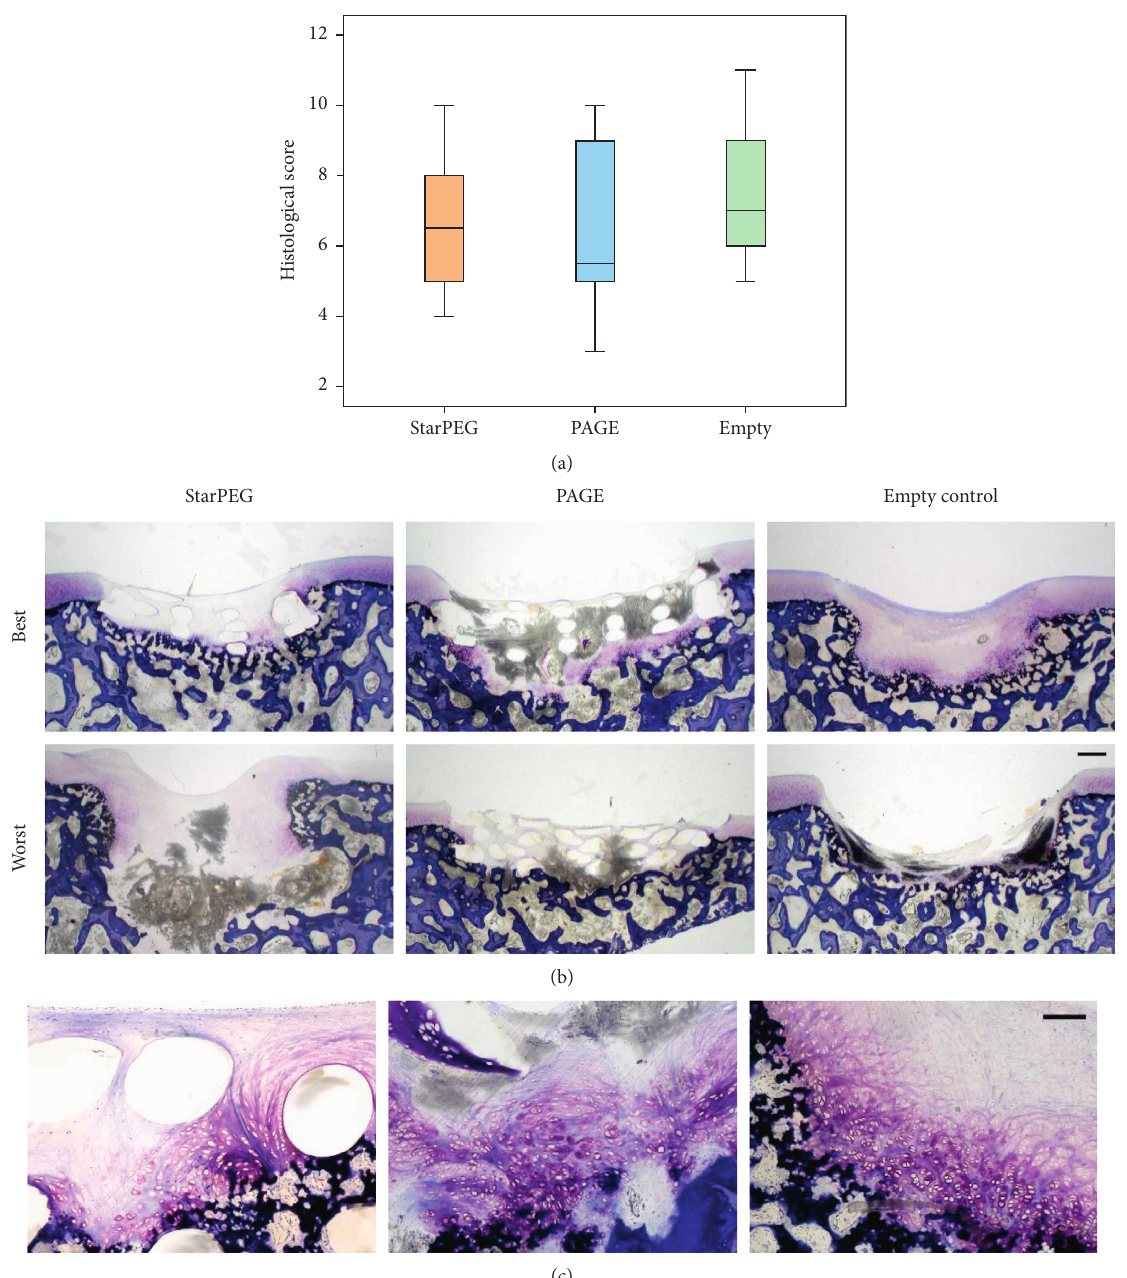
Figure 7: Histology after 12 weeks in vivo . Histological evaluation using modified O‘Driscoll score by two blinded observers. Boxes represent first and third quartiles, medians are given as horizontal lines, and whiskers are maximal and minimal values. StarPEG and PAGE n � 10, empty n � 4, and there was no statistical significance between the groups, ∗ : p ≤ 0 . 05 vs. empty control (ANOVA) (a). Best and worst results per group according to histological scoring (mod. O‘Driscoll score done by two blinded observers). Toluidine blue staining; scale bar: 500 μ m (b). Magnification of best constructs per group regarding cell morphology and metachromasia, toluidine blue staining; scale bar: 200 μ m